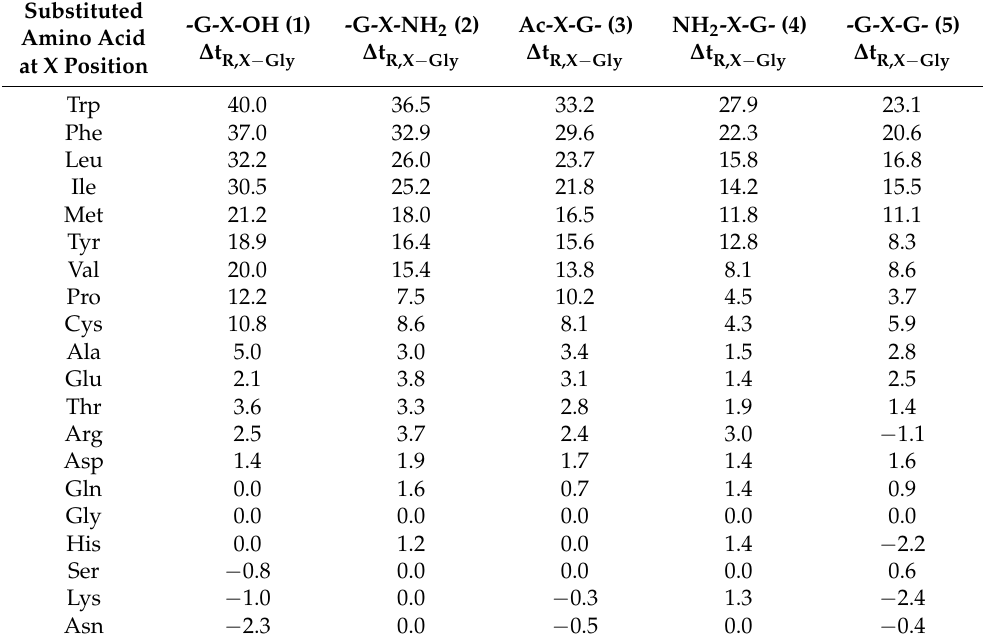
Table 14. Hydrophobicity of peptide models